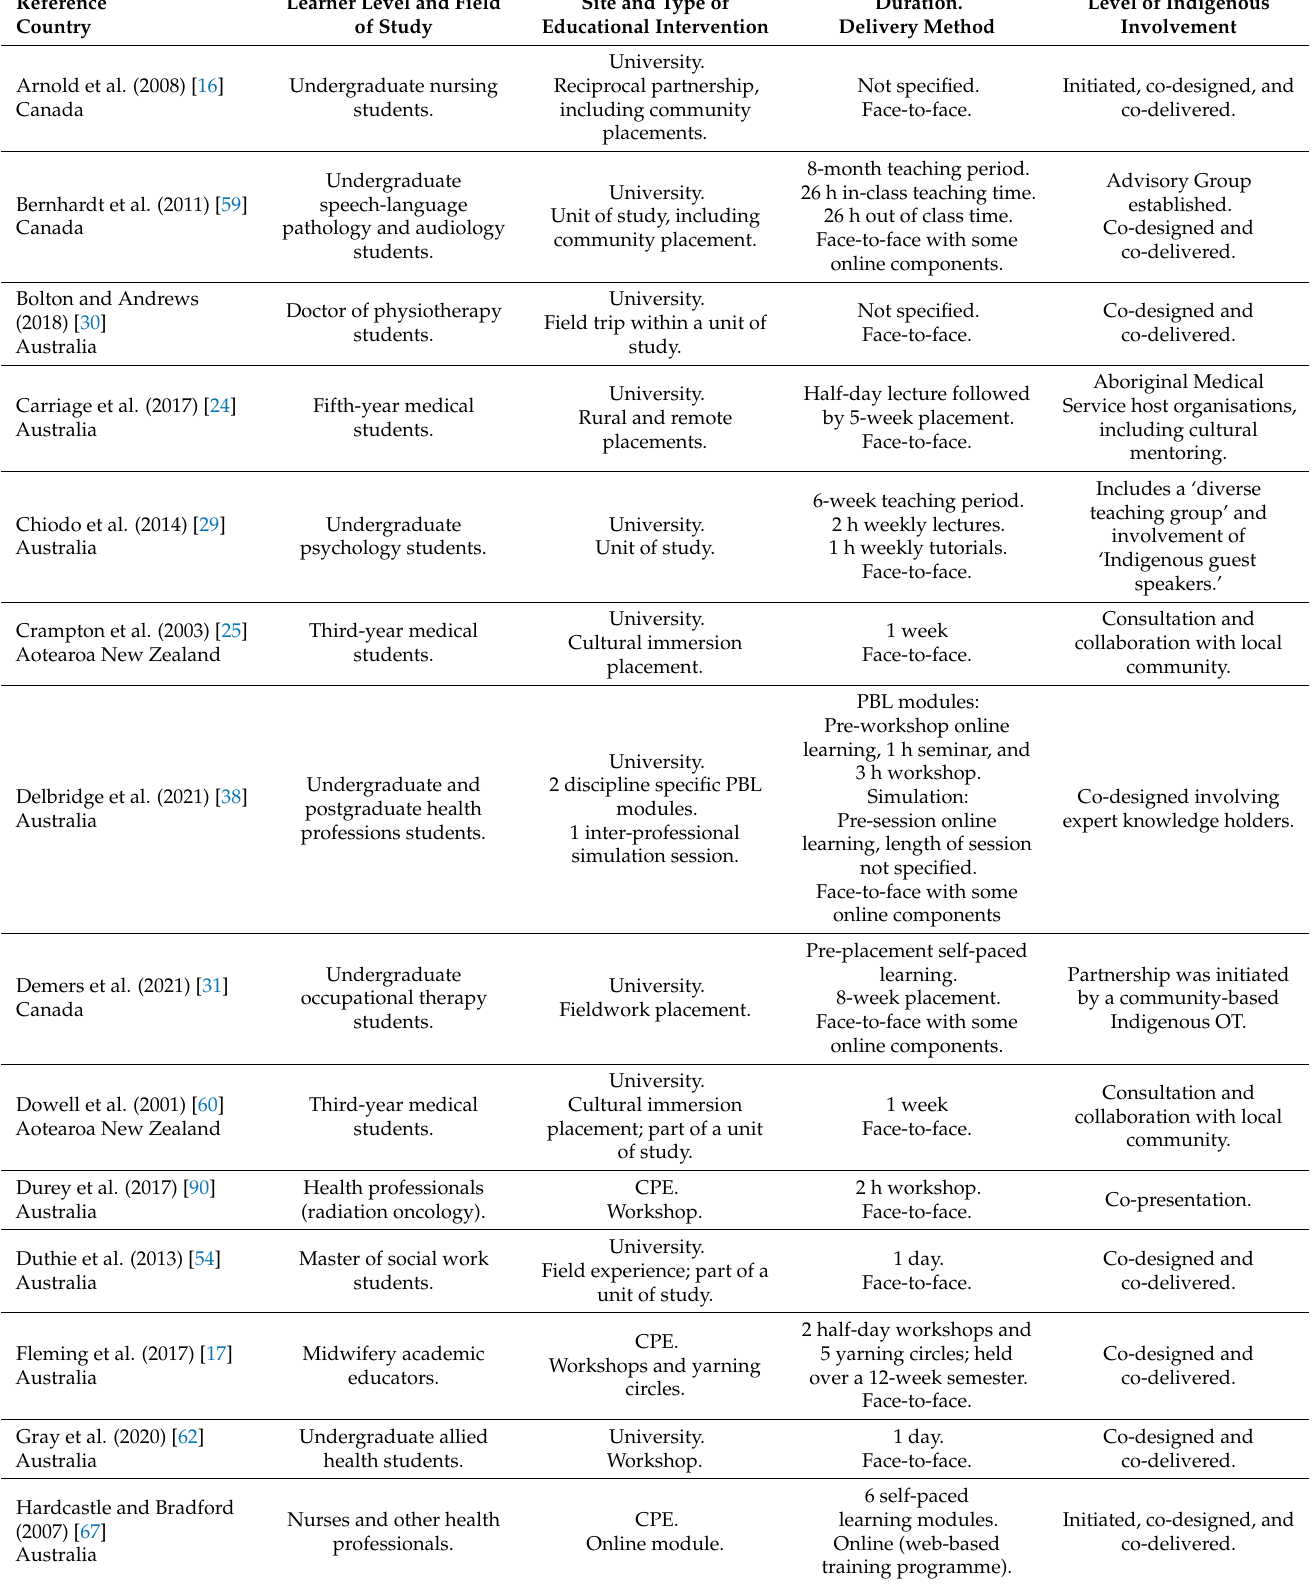
Table 1. Summary of key characteristics of the educational interventions